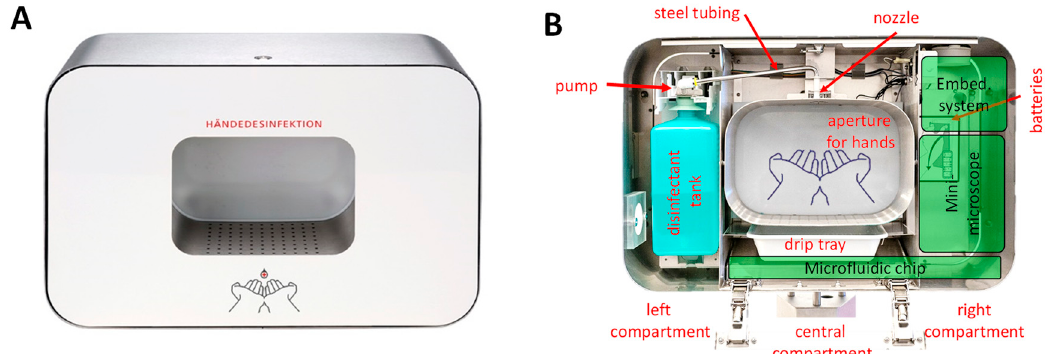
Figure 10. Commercially available dispenser as a platform for a future system integration of our method. ( A ) The front view of the dispenser. The dispenser has a compartment in which the hand-hygiene event takes place. The overall dimension of the dispenser is 337 mm × 506 mm. ( B ) An internal view of the dispenser. The disinfectant tank with the pump is located on the left compartment. The pump is connected with the middle compartment by a steel tubing. At the end of this steel tubing, the nozzle extract the disinfectant in the palm of the hands (central compartment). Below there is a drip tray that could collect the so-called overspray that might contain pathogens. Batteries are located on the right compartment. As there is still enough space, in the future, the drip tray could be replaced by a microfluidic chip to collect and prepare the samples and a miniaturised microscope, microfluidic pumps and an embedded system for data processing could be integrated in order to have everything dispenser-integrated (green boxes in the figure). It is noteworthy that this commercially available dispenser can be equipped with a Bluetooth module or with a power adapter.